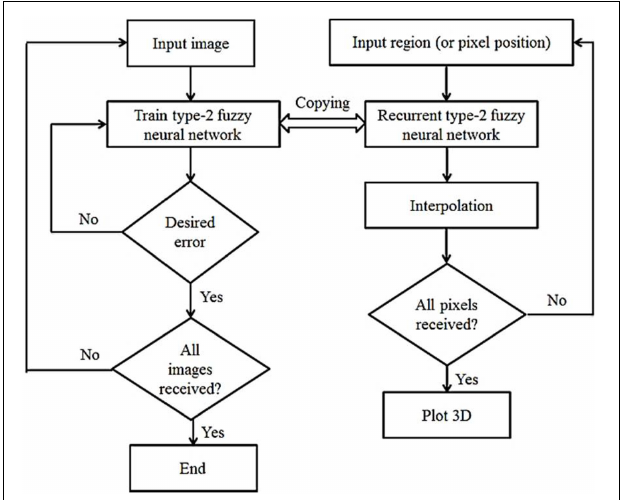
FIGURE 2 | Flowchart of the proposed